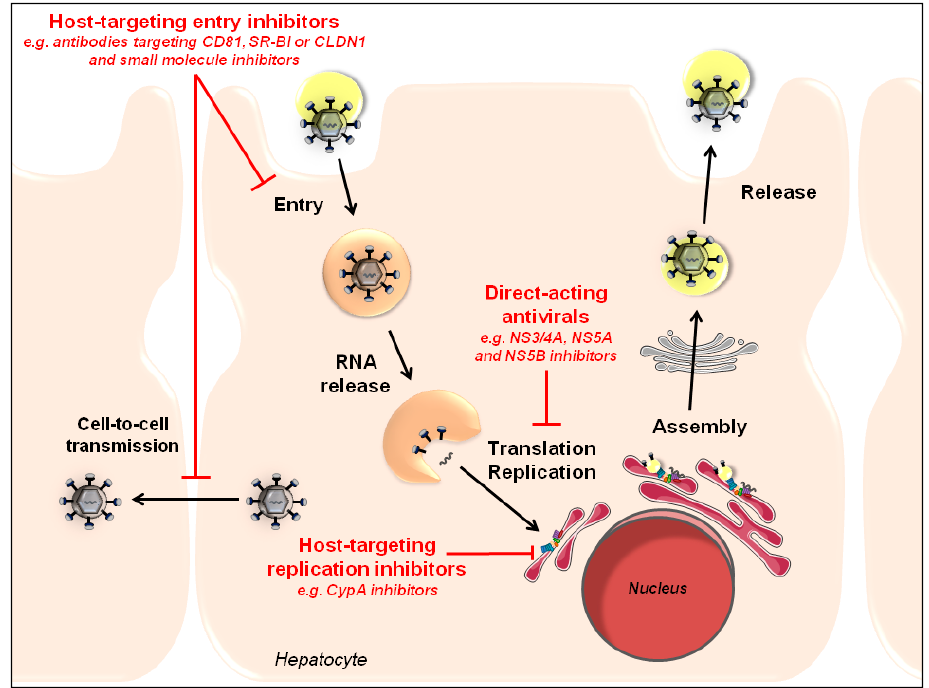
Figure 4. Synergy between HTAs and DAAs to inhibit HCV infection at different steps of the viral life cycle. Given their complementary mechanism of action, HTAs and DAAs can act in a synergistic manner to reduce viral loads and to prevent viral resistance. Different classes of HTAs and DAAs that have been evaluated in combination are highlighted in